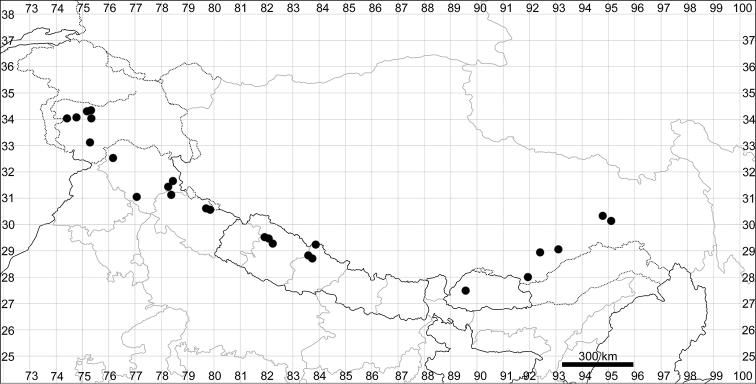
Distribution map of Acroglochinpersicarioides.